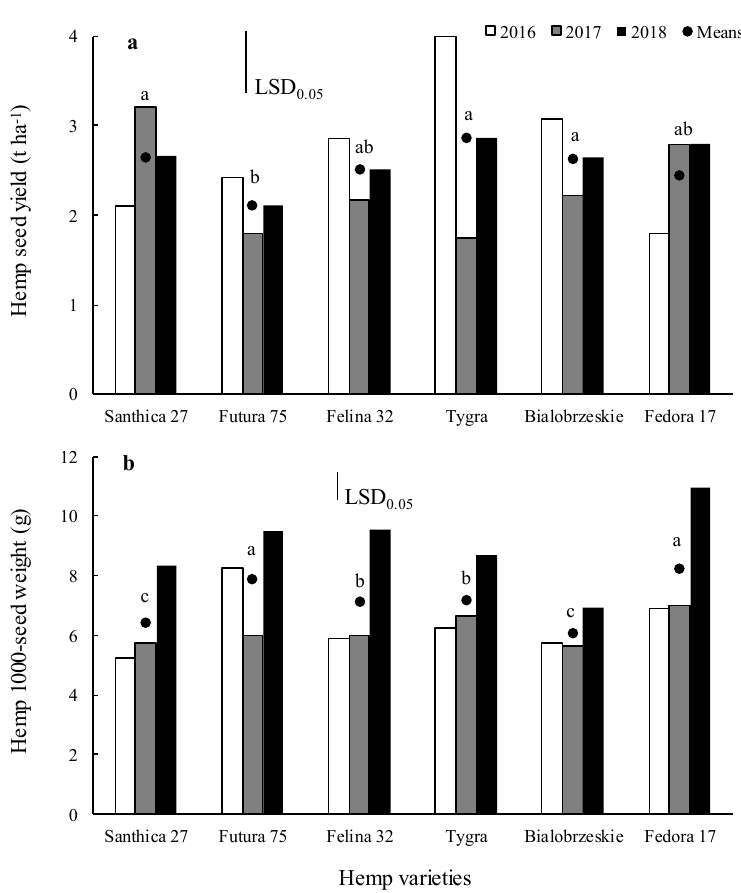
Figure 6. Seed yield ( a ) and 1000-seed weight ( b ) of six industrial hemp varieties. For the year × variety interaction, columns with height differences lower than the LSD height did not significantly differ according to the Fisher’s Protected Least Significant Difference (LSD) test at p = 0.05. For the variety effect, points with the same letter did not significantly differ according to the Fisher’s Protected Least Significant Difference test at p = 0.05.